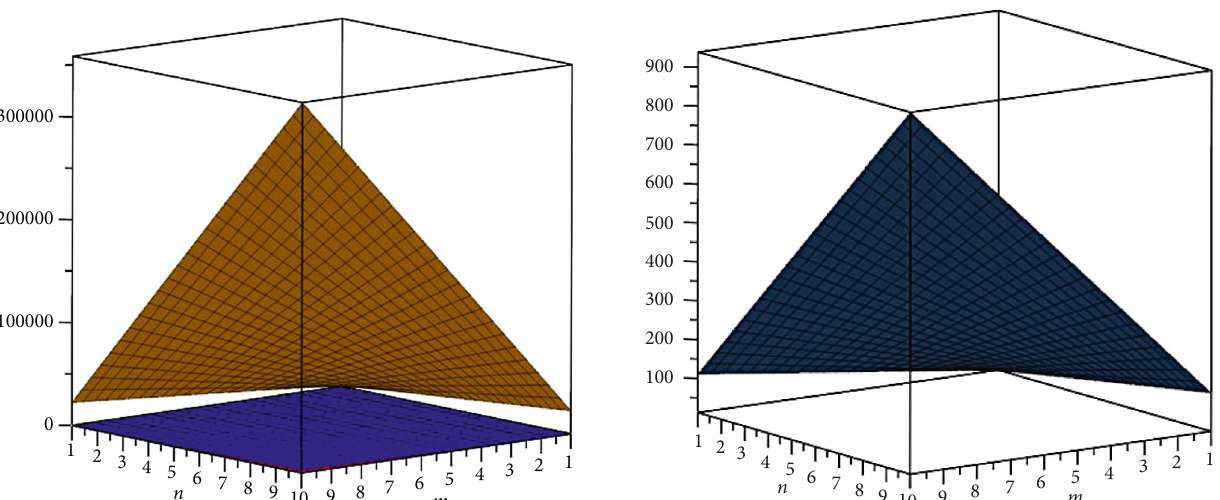
Figure 4: Graphical depiction of Table 4.